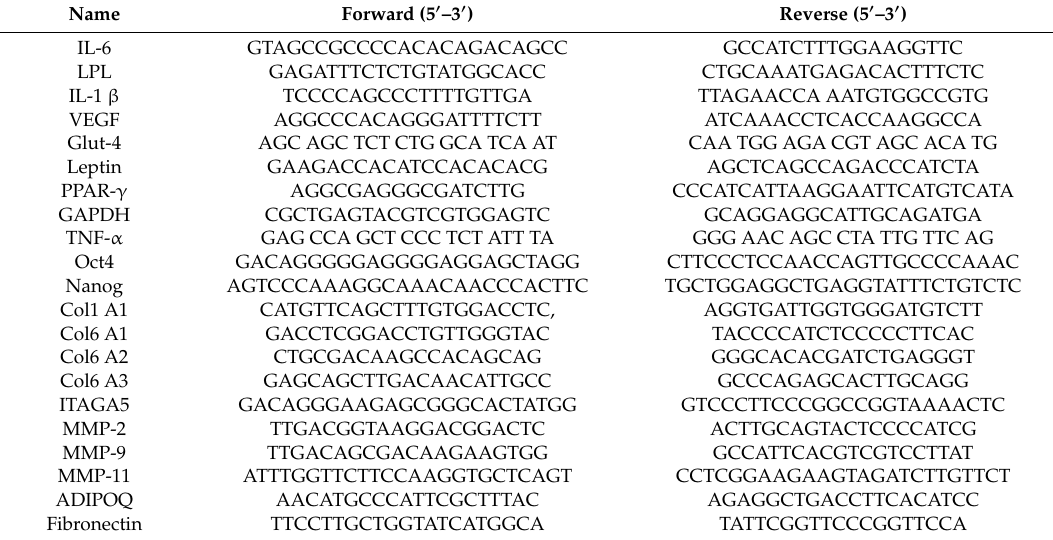
Table 2. List of primers used for